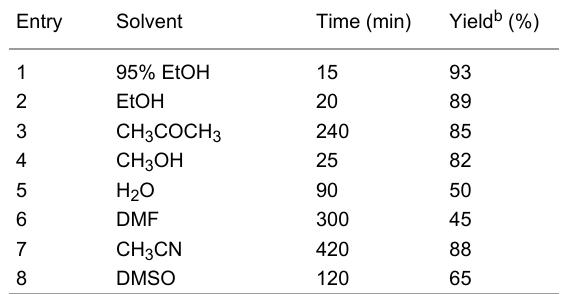
Table 2: Effect of solvent on the cross-coupling reaction a .